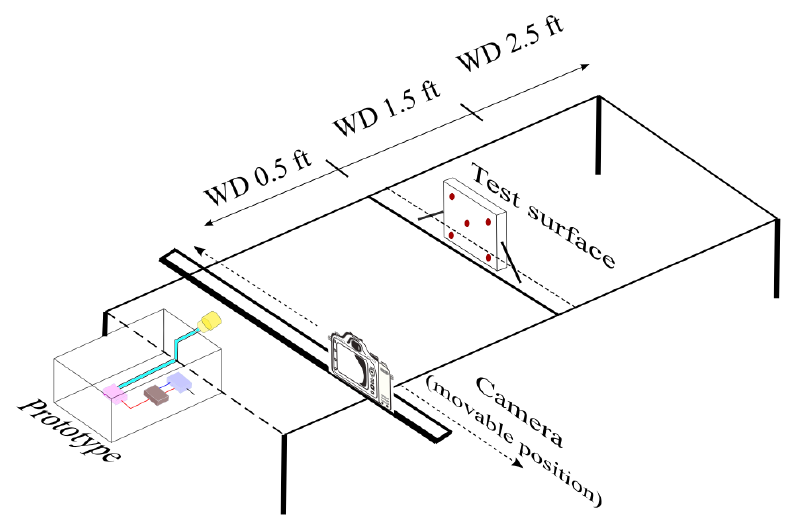
Figure 3. Schematic of the experimental setup of the electrostatic spray deposition for varying system